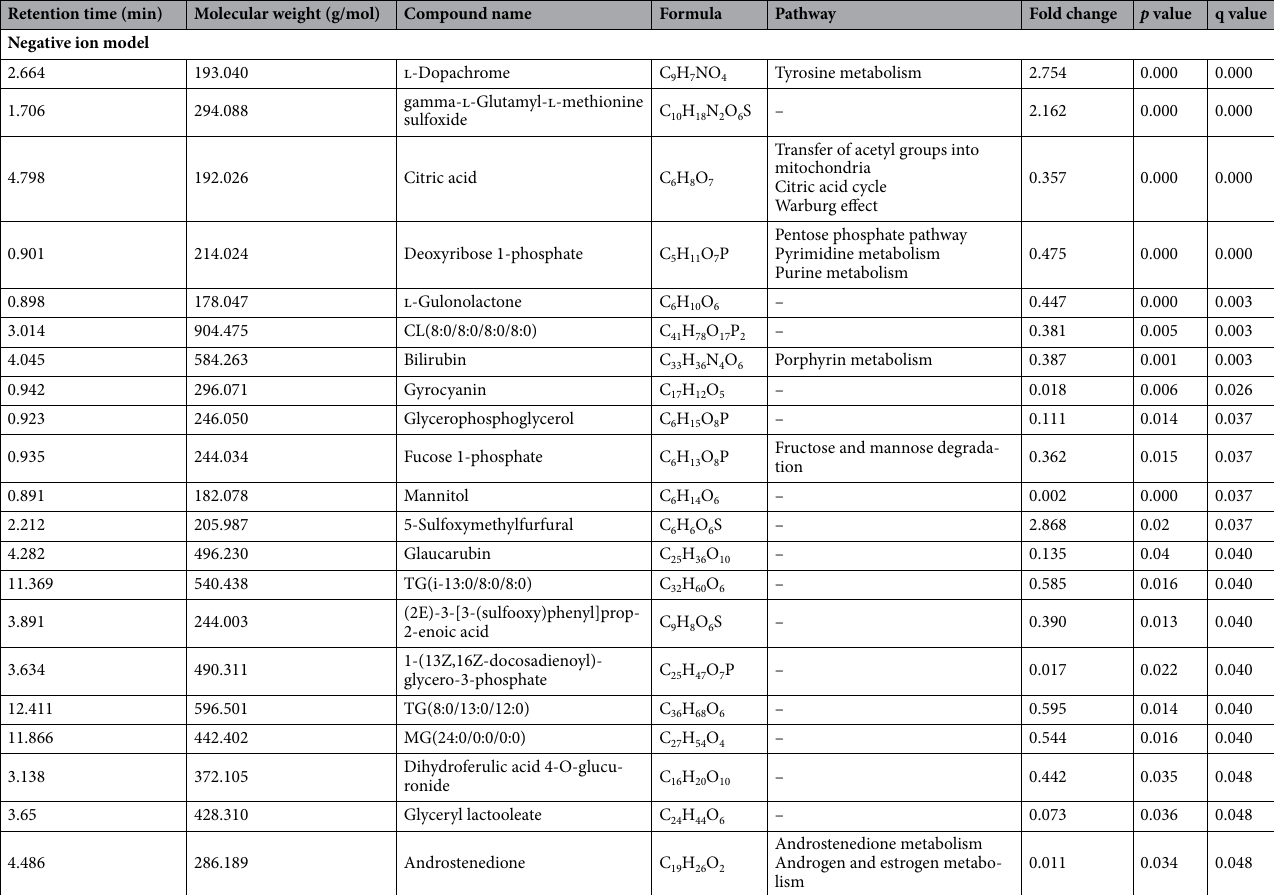
Table 2. Identified metabolites in negative ion model related to NC-AME based on UPLC-Q-TOF/MS. Q-values are the adjusted p values using an optimized FDR